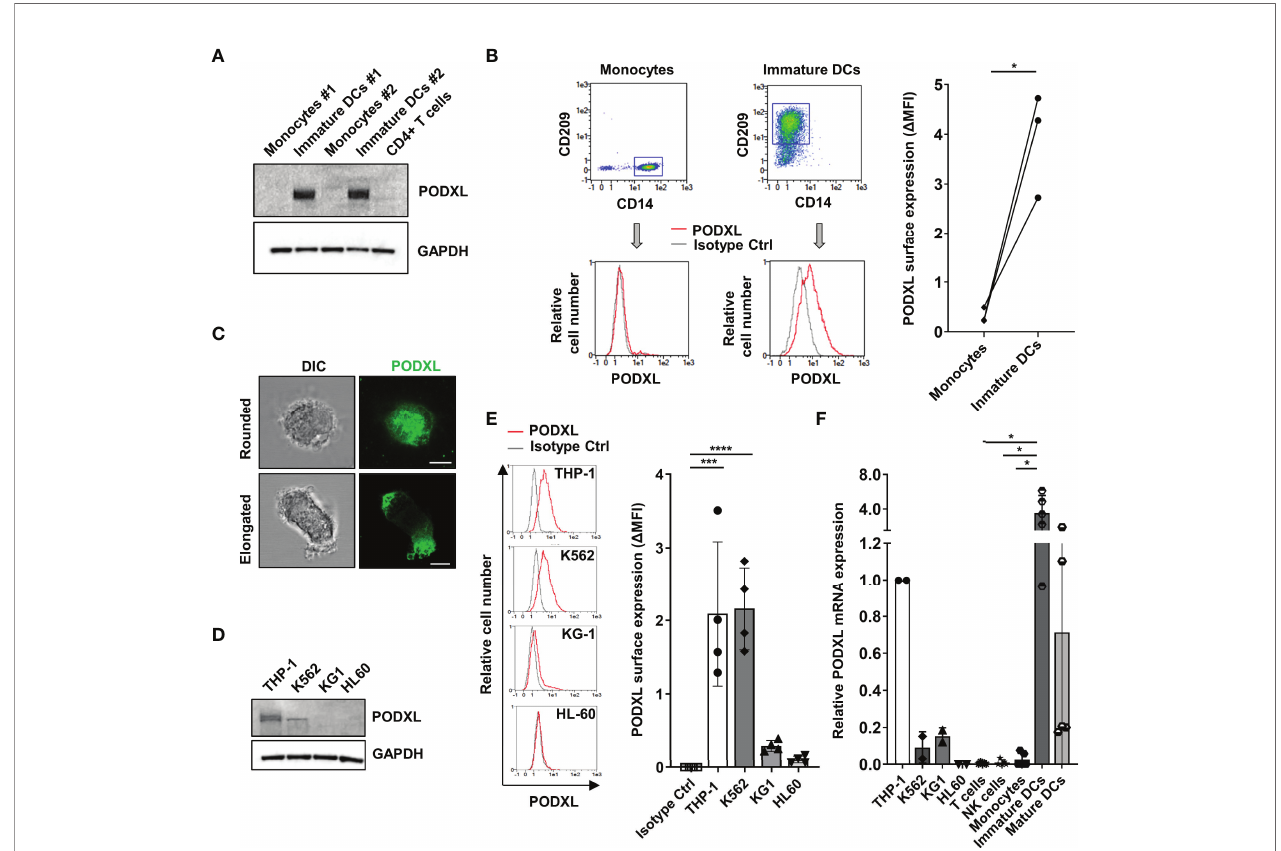
FIGURE 1 | PODXL is expressed in human monocyte-derived immature DCs. (A) Determination of PODXL expression in total lysates from human monocytes and monocyte-derived immature DCs from two donors and CD4 + T cells from one donor by Western blot analysis using a speci fi c mouse anti-human PODXL monoclonal antibody. GAPDH was used as loading control. The blot shown is representative of two independent experiments. (B) Flow cytometry gating and overlay histograms depicting the surface expression of PODXL on monocytes (CD14 + CD209 - ) and immature DCs (CD14 - CD209 + ) detected by fl ow cytometry using a biotinylated goat anti- human PODXL antibody (red line) or an isotype control (grey line) followed by PE-conjugated streptavidin from one representative donor. The graph shows PODXL surface expression ( D MFI= PODXL MFI - isotype control MFI) on monocytes and immature DCs from three donors. *p < 0.05, paired t test. (C) Expression of PODXL in monocyte- derived immature DCs by fl uorescence microscopy. Monocyte-derived immature DCs were deposited onto glass slides using a cytospin and incubated in complete culture medium for 30 min. Cell were stained with a goat anti-PODXL polyclonal antibody followed by an anti-goat Cy2-labelled secondary antibody (green). Images were acquired with a 63x objective using a confocal fl uorescence microscope and are representative of ten rounded and twelve elongated immature DCs photographed from three independent experiments. Example shows maximal intensity z-projections of confocal fl uorescence sections. DIC, differential interference contrast. Scale bar corresponds to 5 m m. (D) Determination of PODXL expression in cell lysates from different myelomonocytic cell lines by Western blot analysis using a speci fi c anti-PODXL monoclonal antibody. GAPDH was used as loading control. The blot shown is representative of two independent experiments. (E) Overlay histograms showing the surface expression of PODXL on four different myeloid cell lines determined by fl ow cytometry using a biotinylated goat anti-human PODXL antibody (red line) or an isotype control (grey line) followed by PE-conjugated streptavidin from one representative experiment. Graph shows mean ± SD of PODXL surface expression ( D MFI= PODXL MFI - isotype control MFI) from four independent experiments. ***p < 0.001, ****p < 0.0001, one-way ANOVA. (F) Analysis of PODXL mRNA level by RT-PCR in four myelomonocytic cell lines and in T cells, NK cells, monocytes, monocyte-derived immature and mature DCs. Results are depicted relative to THP-1 cells. *p < 0.05, Krustal-Wallis